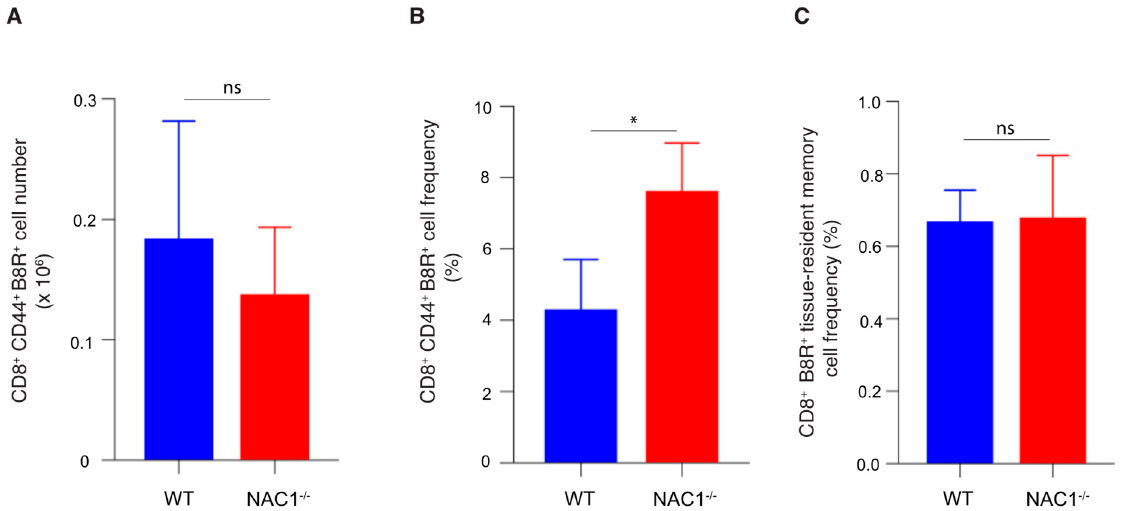
Figure 6. Enhanced CD8 + T cell memory formation in NAC1 − / − mice. Quantification for T cell memory population after 35 days. The mice were sacrificed on day 35. The spleen and lymph nodes were dissected and smashed. The total live cell number for each mouse was calculated with trypan blue staining through a Bio-Rad cell counter. T cell surface markers were stained before flow cytom- etry. ( A ) The VACV-specific memory CD8 + T cell (CD8 + CD44 + B8R + ) number for each mouse had been calculated and compared between WT and NAC1 − / − groups. ( B ) The VACV-specific memory CD8 + T cell (CD8 + CD44 + B8R + ) frequency for each mouse was collected and analyzed. The p -value is 0.040. ( C ) Tissue-resident memory (CD44 hi CD69 hi CD197 low ) T cell frequency had been analyzed between WT and NAC1 − / − groups. (*, p < 0.05; ns, p > 0.05).